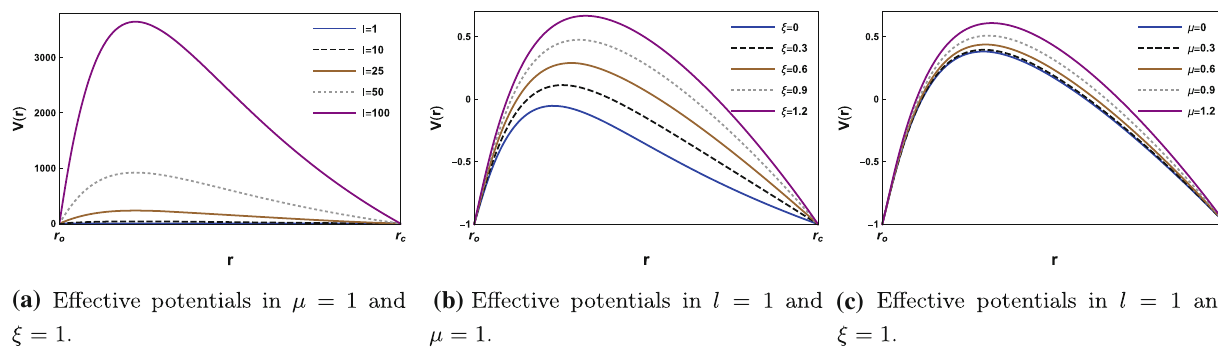
Fig. 1 Effective potentials in M = 0 . 3 and ω = 1 with respect to l , ξ , and